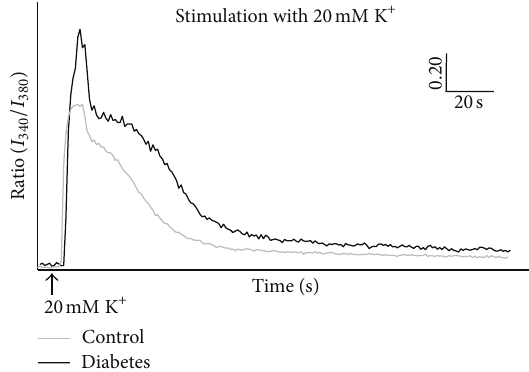
Figure 3: Example of time-[Ca 2+ ] 𝑖 ratio development in dorsal root ganglion neurons from control and diabetic rats. The neurons were stimulated with 20mM K + . For clarity in the illustration, the traces were background corrected. Arbitrary scale; vertical scale: 0.20 (340/380 nm light intensity ratio), and horizontal scale: